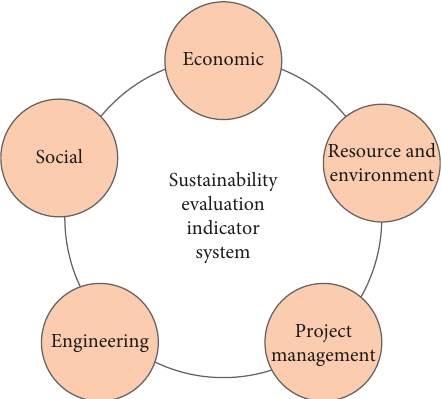
Figure 2: The sustainability evaluation indicator system of water environmental treatment PPP